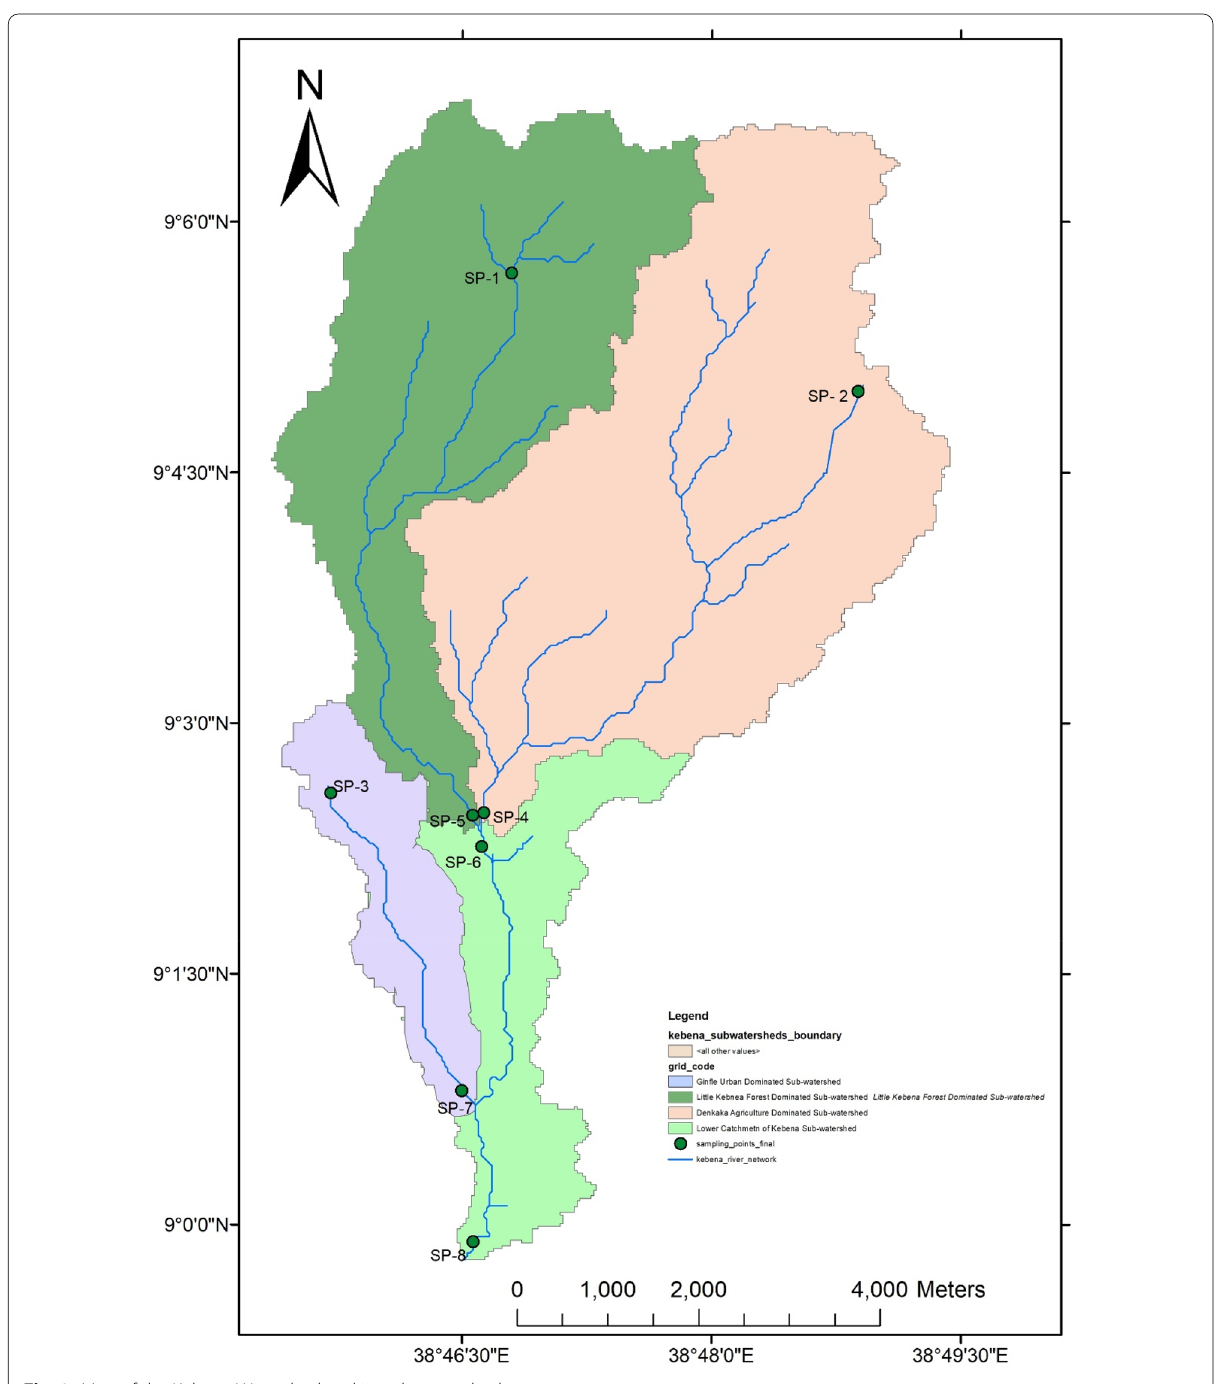
Fig. 3 Map of the Kebena Watershed and its